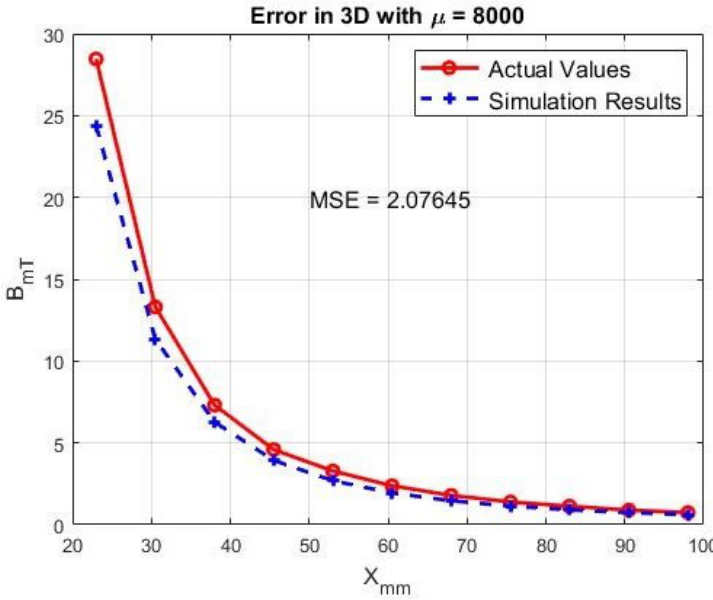
Figure 5. Actual and simulated magnetic field.